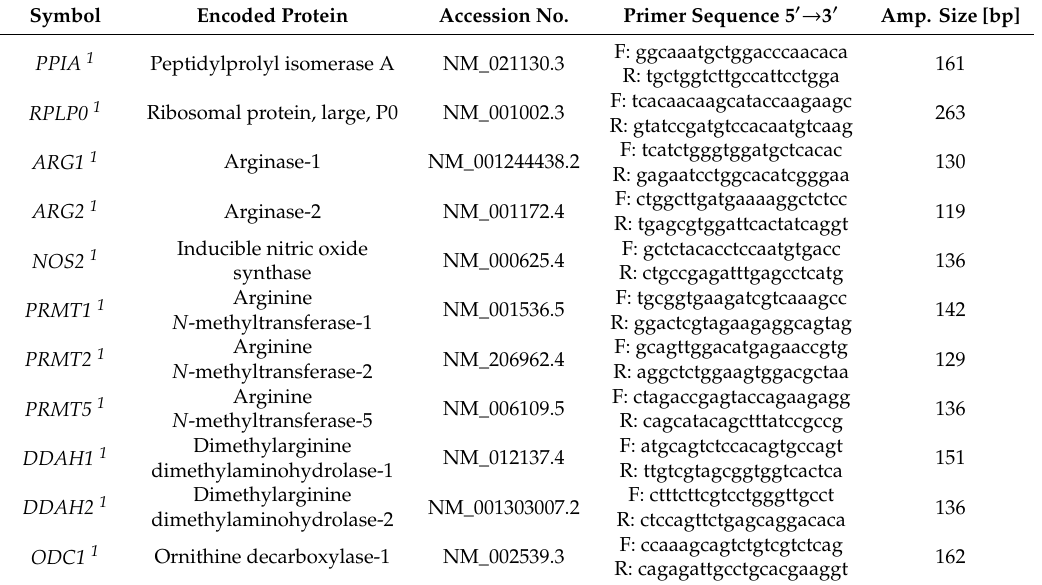
Table 8. Primers’